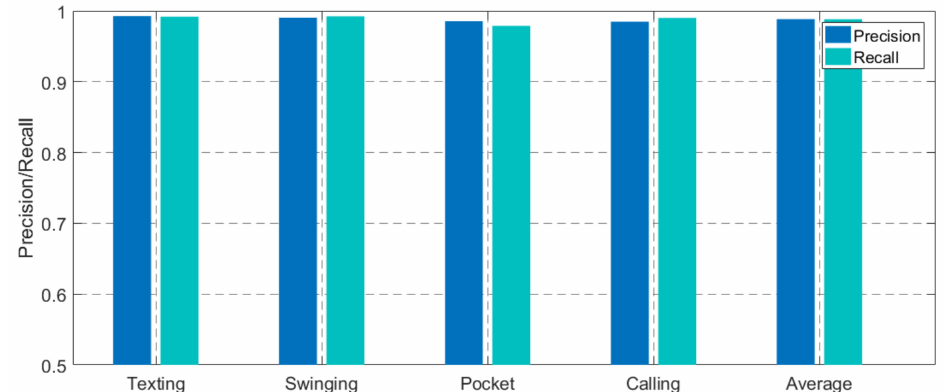
Figure 9. Average accuracy of the proposed posture context awareness algorithm. The rightmost two bars are the average precision and recall rate of the four different